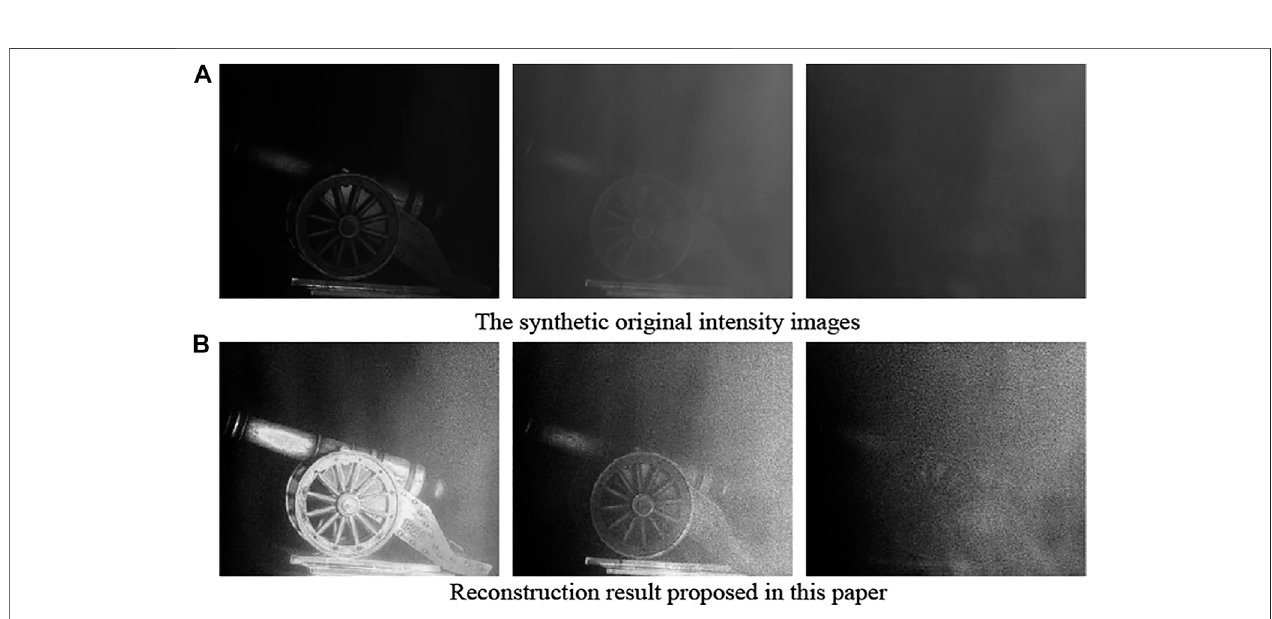
FIGURE 14 | Figure processing under the condition of different density of medium with bubble density is bubble 3. (A) The synthetic original intensity images. (B) Reconstruction result proposed in this paper.